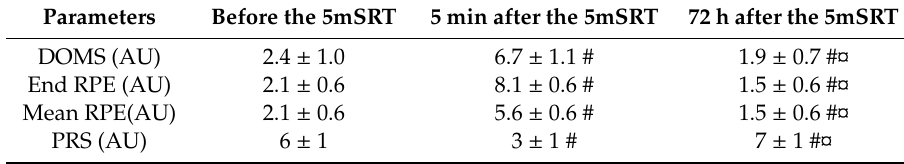
Table 2. Delayed onset muscle soreness (DOMS), rating of perceived exertion (RPE), and perceived recovery status (PRS) scores recorded before, 5 min and 72 h after the